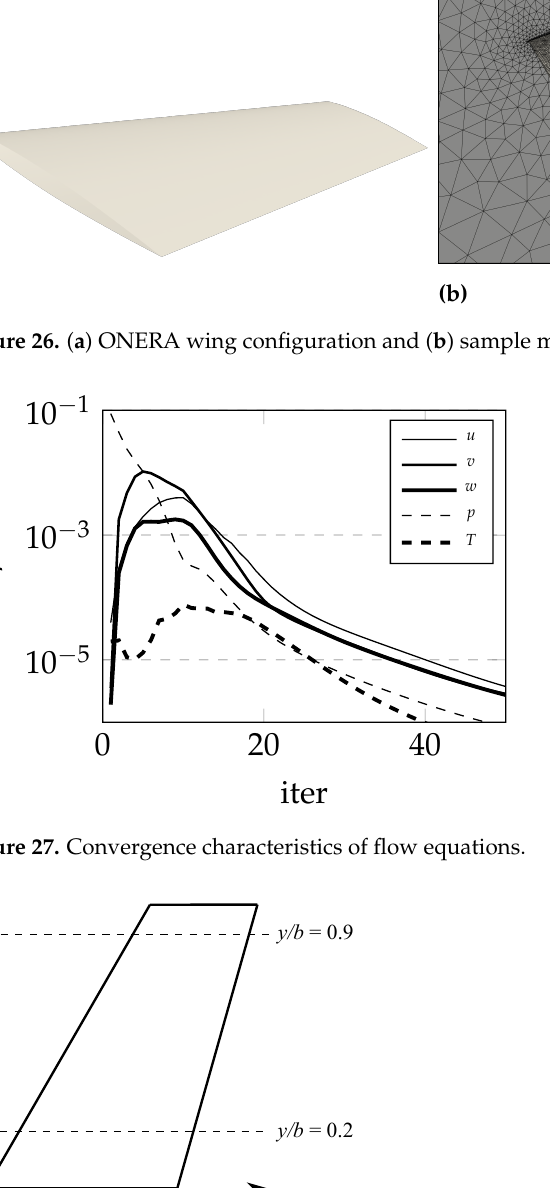
Figure 28. Schematic of the ONERA wing showing a top-view and the two associated section lines